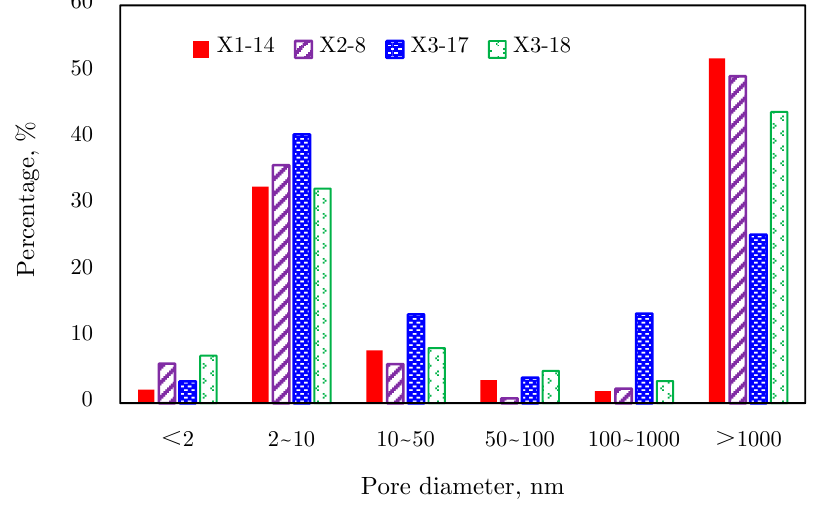
Figure 16. PSD histogram of samples from the Longmaxi Formation in the Sichuan Basin based on N 2 adsorption and MICP.